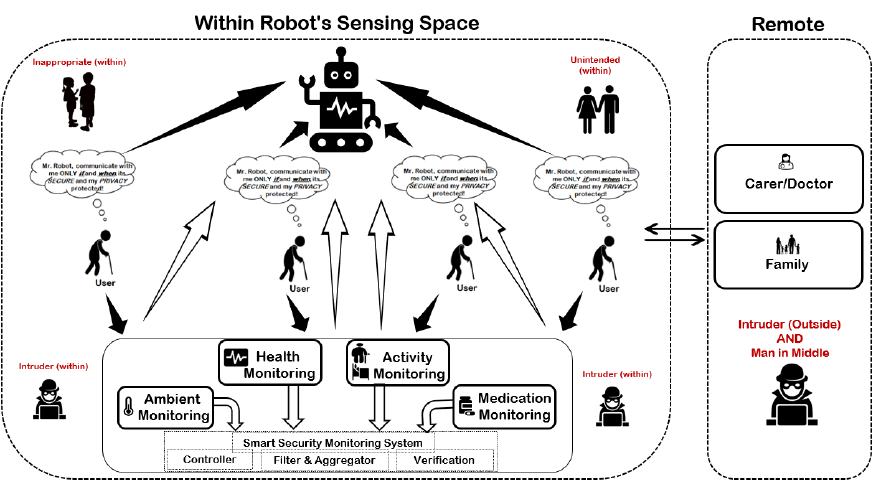
Figure 5. Threat Modelling of Multiuser Single AMRSys with IoT.